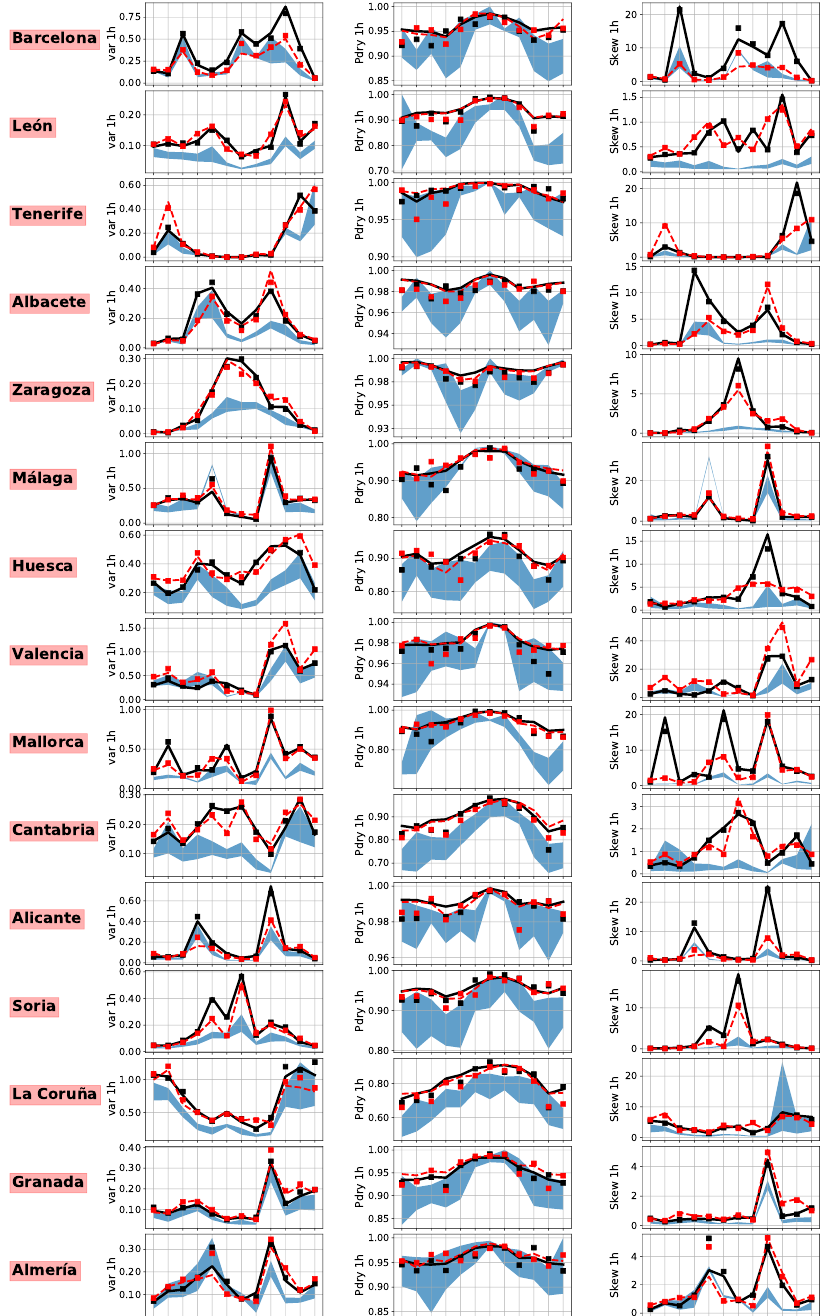
Figure 6. One-hour rainfall performance of the NSRPM simulation of variance, Pdry, and skewness. Black color corresponds to the “exact scenario”; the line and squares represent, respectively, the observed and simulated 1-h statistics. Red color corresponds to the “target scenario”; the dashed-line and squares represent, respectively, the RFB-predicted and the simulated 1-h statistics. The blue-hatched area shows the range of statistics for the calibration in the “simple scenario”. Each row corresponds to a case